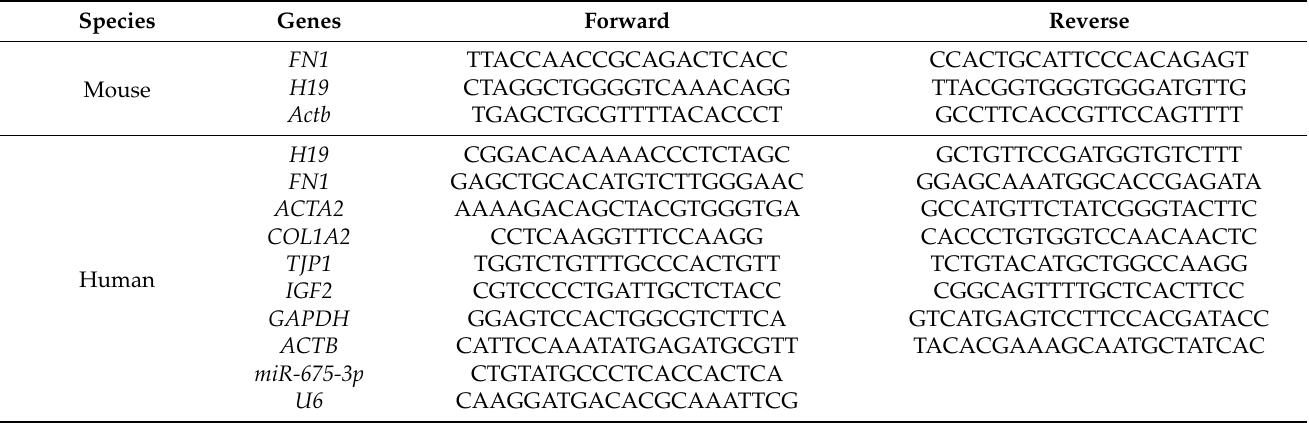
Table 1. Nucleotide sequences of primers used in this